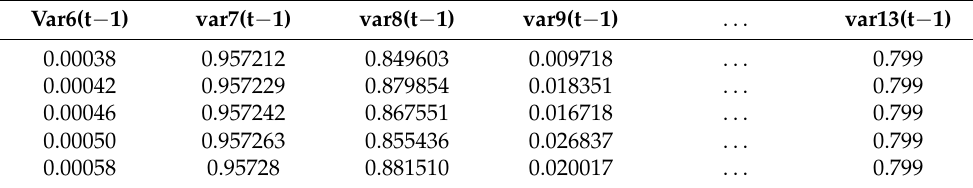
Table 3. Sample of multivariable sequence